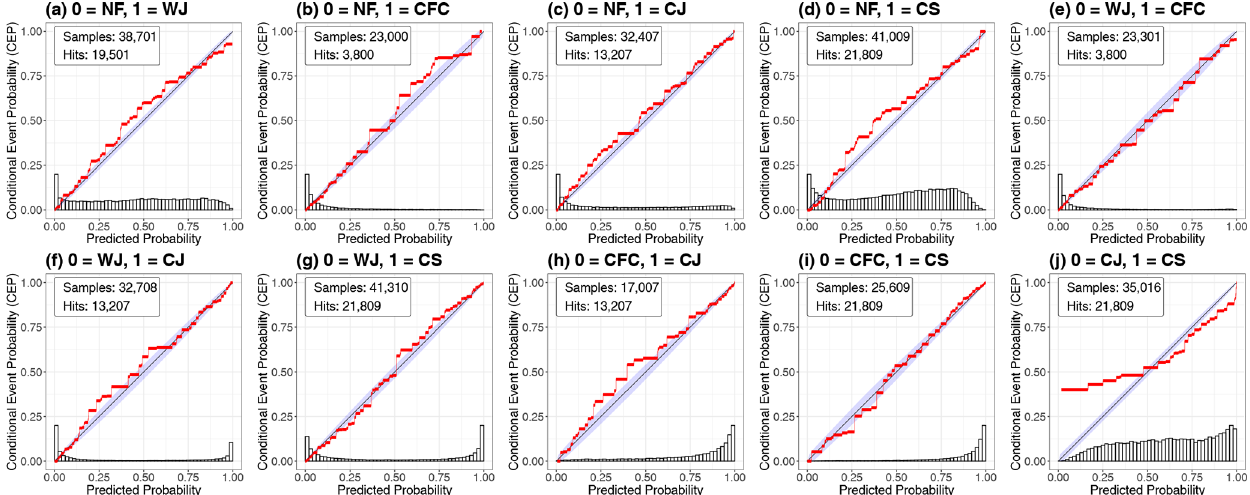
Figure 7. CORP reliability diagrams of the conditional RF probabilities comparing two wind features in the all-pairs approach including all 12